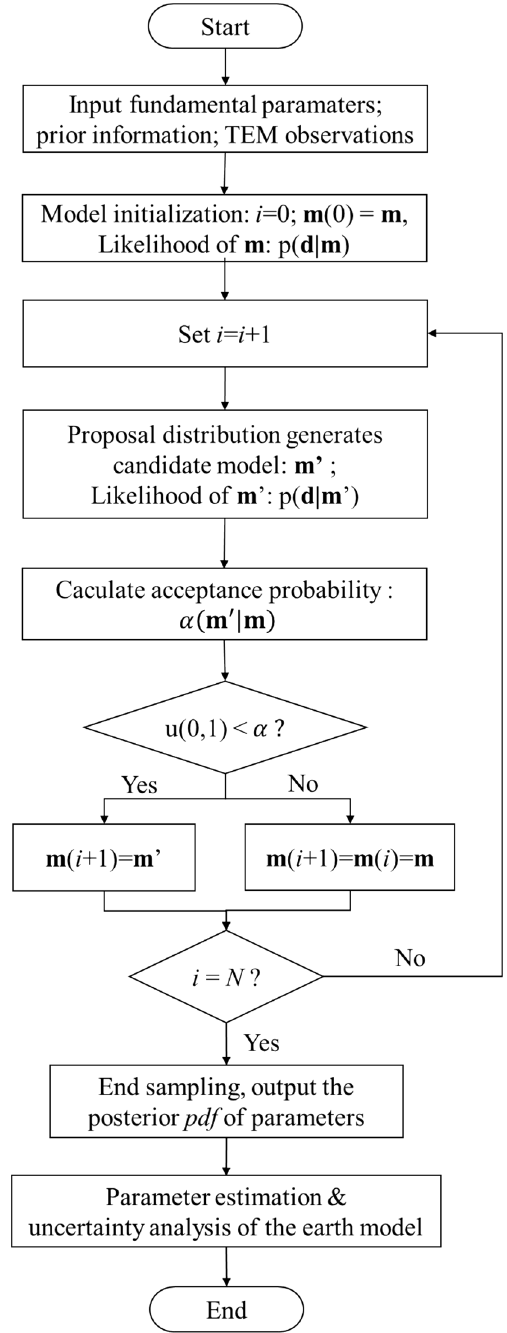
Fig. 1 Flowchart illustrating the Bayesian MCMC inversion of sur- face-based TEM